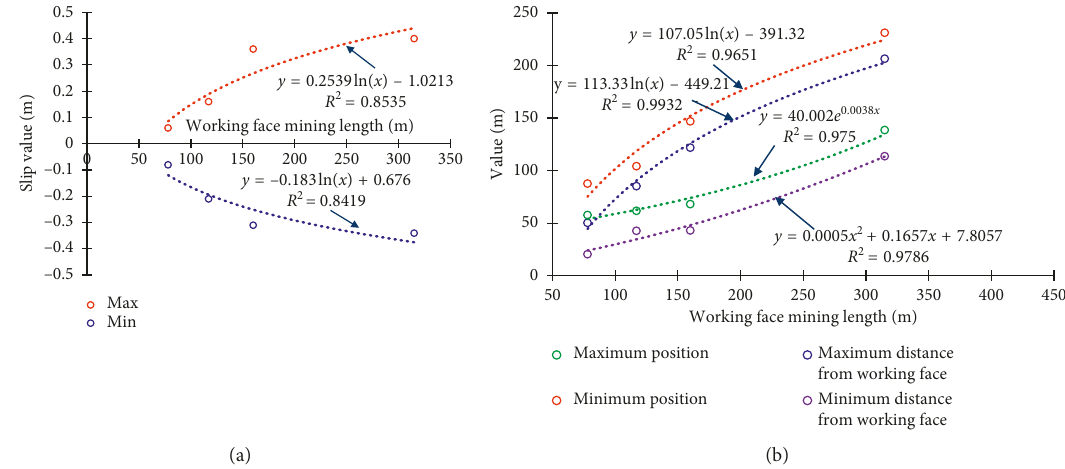
Figure 14: Evolution curves of maximum and minimum slip values and their positions. (a) Variation curves of maximum and minimum slip. (b) Evolution curves of maximum and minimum slip positions.